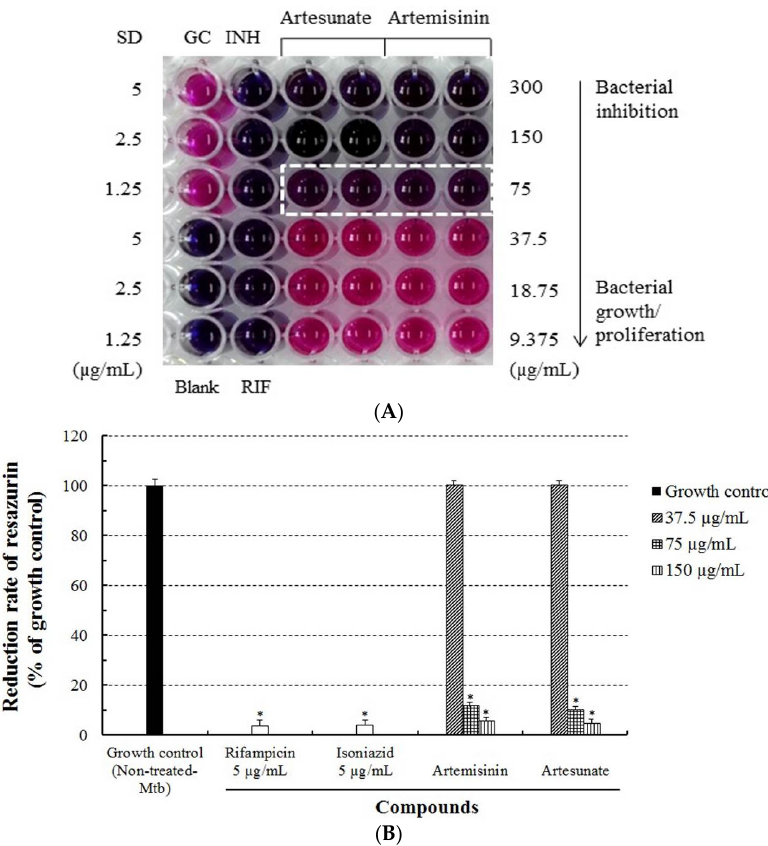
Figure 2. The in vitro anti ‐ Mtb activity/effect of artesunate and artemisinin against Mtb H37Rv measured using the REMA. ( A ) The viability of Mtb determined by a change in color of the REMA; and ( B ) the quantification analysis of the REMA that indicates the Mtb inhibitory rate of the compounds. Mtb was incubated with different concentrations (9.375–300 μ g/mL) of the compounds, respectively. The blue color and dotted lines show the anti ‐ Mtb activity/effect, and the pink color indicates bacterial growth. (GC; growth controls containing no antibiotic, Blank; blank controls without inoculation, SD; standard reference drugs (INH; isoniazid, RIF; rifampicin, 1.25–5 μ g/mL)). All results were expressed as mean ± standard deviation (S.D.) of three independent experiments. * p < 0.05 was considered to be statistically significant.